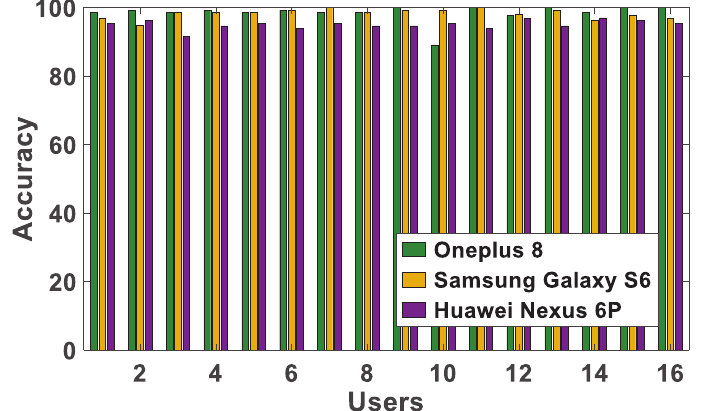
Figure 15. Authentication accuracy by different